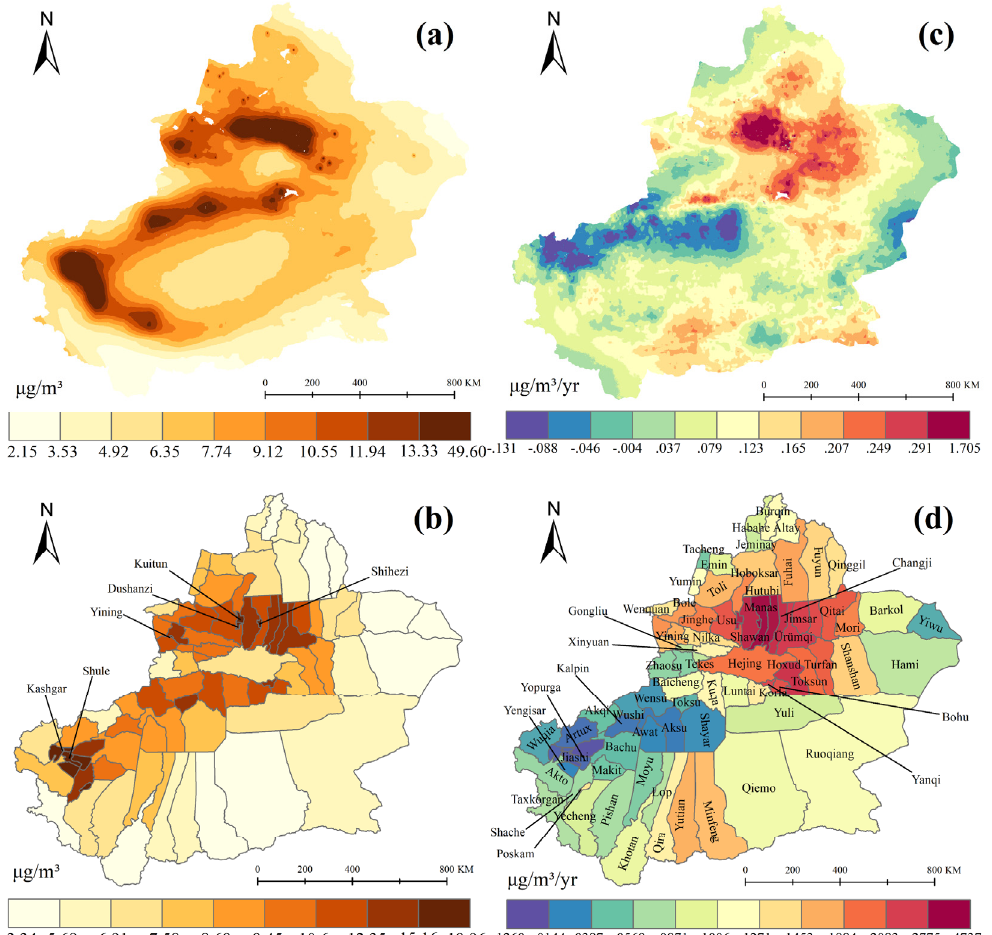
Figure 4. Spatial distributions of ( a , b ) average annual PM 2.5 concentrations ( µ g / m 3 ), ( c , d ) linear trends of annual PM 2.5 concentrations ( µ g / m 3 / yr) in Xinjiang from 2001 to 2016. Figure 4b,d represents the average annual PM 2.5 concentrations ( µ g / m 3 ) and linear trends of annual PM 2.5 concentrations ( µ g / m 3 / yr) at the county level.